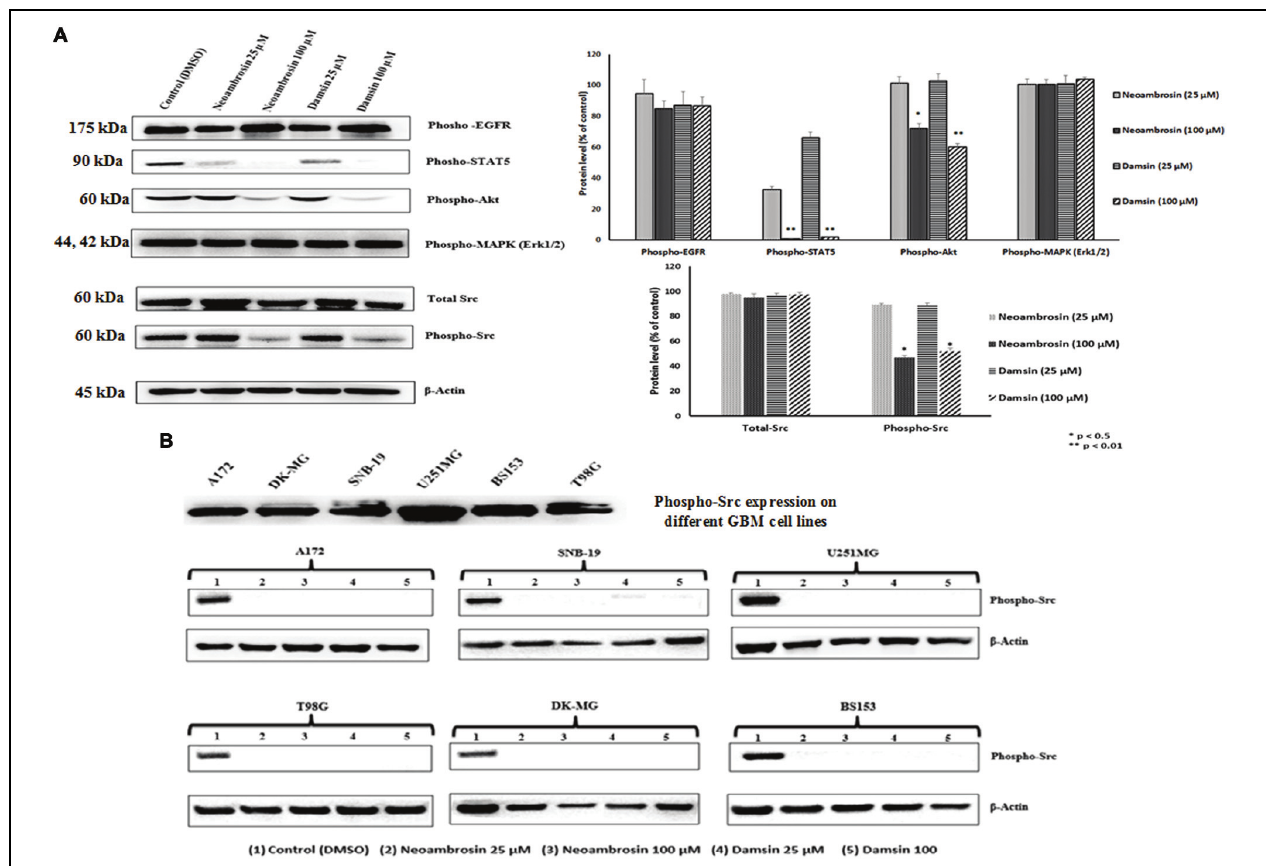
FIGURE 3 | Western blot analysis of the effect of neoambrosin (1) and damsin (2) on EGFR and its downstream signaling cascade proteins. (A) Effect on phosphorylation of (cid:2) EGFR, STAT5, Akt, MAPK (Erk1/2), c-Src, and total c-Src. Bands were normalized to β -actin in order to obtain numerical values (Mean ± SEM). Bars of the average and error bars of three independent experiments are shown. Statistical analysis was done by paired student’s t -test ∗∗ p < 0.01, ∗ p < 0.05; paired t- test. (B) Effect on phosphorylation of c-Src in different GBM cell lines that highly overexpressed c-Src (A172, DK-MG, SNB-19, U251.MG, BS153, and T98G). β -actin was used as loading control.